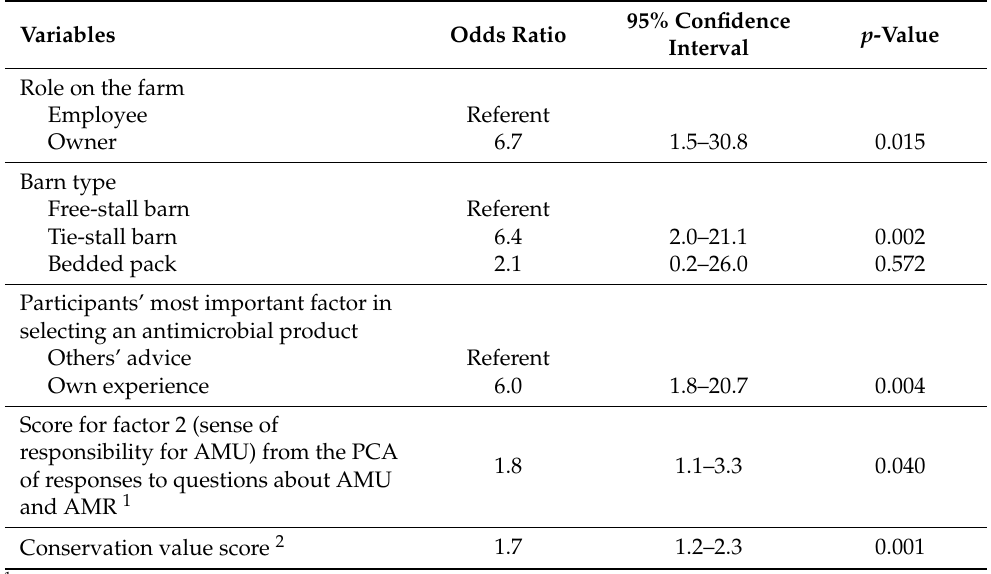
Table 4. Final logistic regression model for the odds of answering no to the question “Should there be more initiatives to promote responsible use of antibiotics in the dairy industry?” from 129 responses in a survey of Canadian dairy